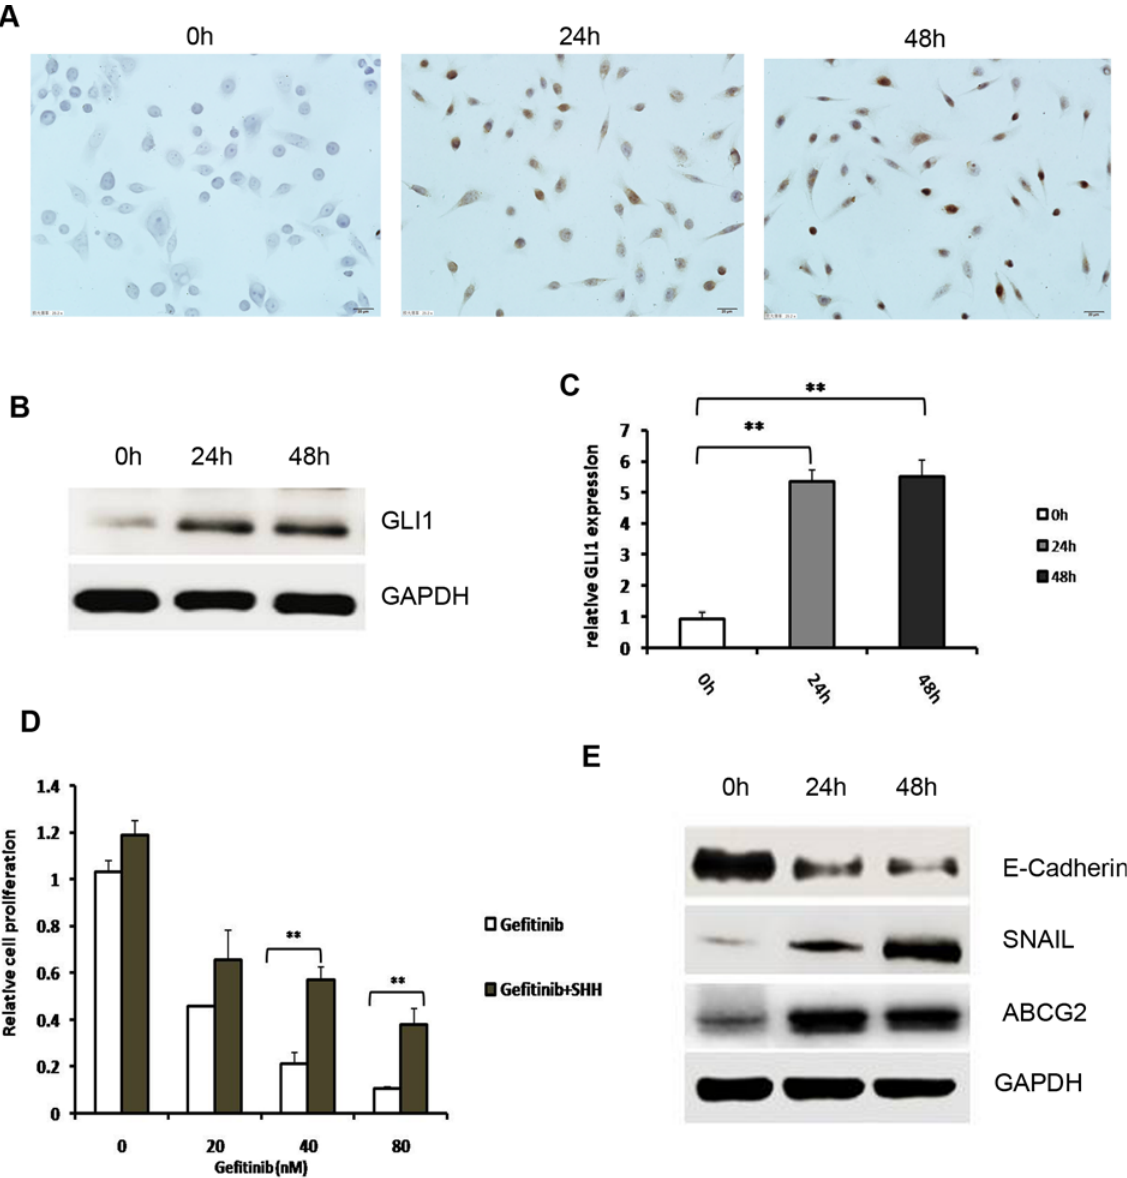
Fig 2. Upregulation of Hh signaling pathway activity by exposure to SHH lead to gefitinib tolerance accompanied by EMT induction and ABCG2 upregulation in EGFR-TKI-sensitive NSCLC cells. (A) Immunocytochemical analysis of GLI1 in PC9 cells after N-Shh (0.5 μ g/mL) treatment for 0, 24, and 48h. GLI1 expression in PC9 cells was negative without exposure to N-Shh. GLI1 was expressed in the nuclei after N-Shh treatment for 24 and 48 h. (B) Western blot analysis of GLI1 in PC9 cells after N-Shh (0.5 μ g/mL) treatment for 0, 24, and 48h. (C) Q-PCR analysis of GLI1 mRNA relative expression in PC9 cells after N-Shh (0.5 μ g/mL) treatment for 0, 24, and 48h; GLI1 expression was obviously elevated after exposure to N-Shh for 24 h and 48 h; ** ( P < 0.01). (D) Proliferation of PC9 cells was assessed by MTT assay after treatment with the indicated concentrations of gefitinib with or without pre-exposure to extrinsic N-Shh (0.5 μ g/mL) for 24h; compared with the gefitinib single-agent group, exposure to extrinsic N-Shh significantly increased gefitinib tolerance in PC9 cells ** ( P < 0.01). (E) Western blot analysis of E-Cadherin, Snail and ABCG2 in PC9 cells after N-Shh (0.5 μ g/mL) treatment for 0, 24, and